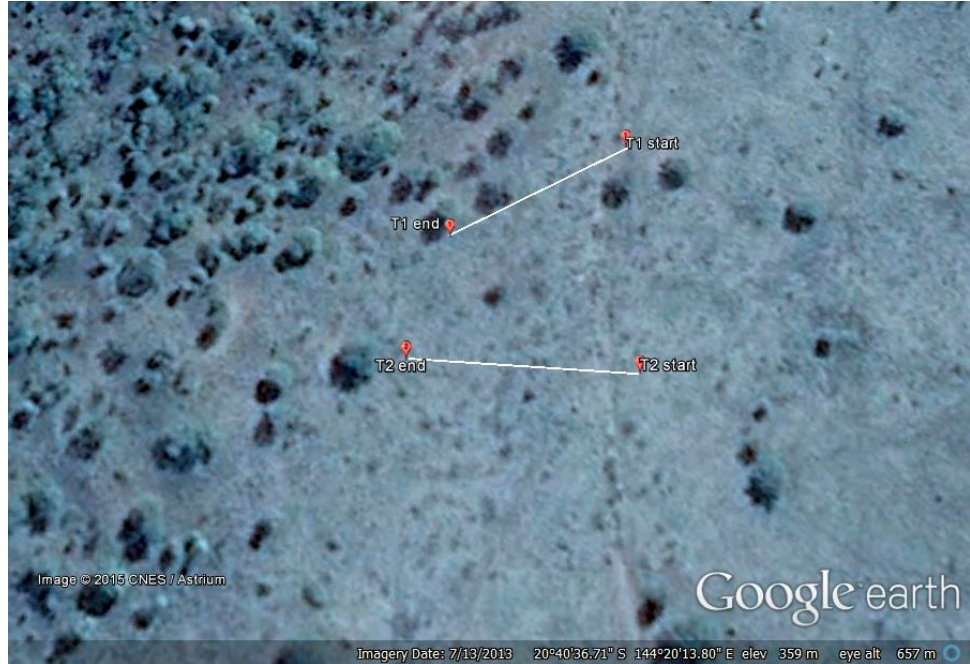
Figure 4. Satellite image of 50 m transects at Koon Kool Station one year after the final assessment (2013) [16]. Parkinsonia stand observed in 2004 no longer visible.